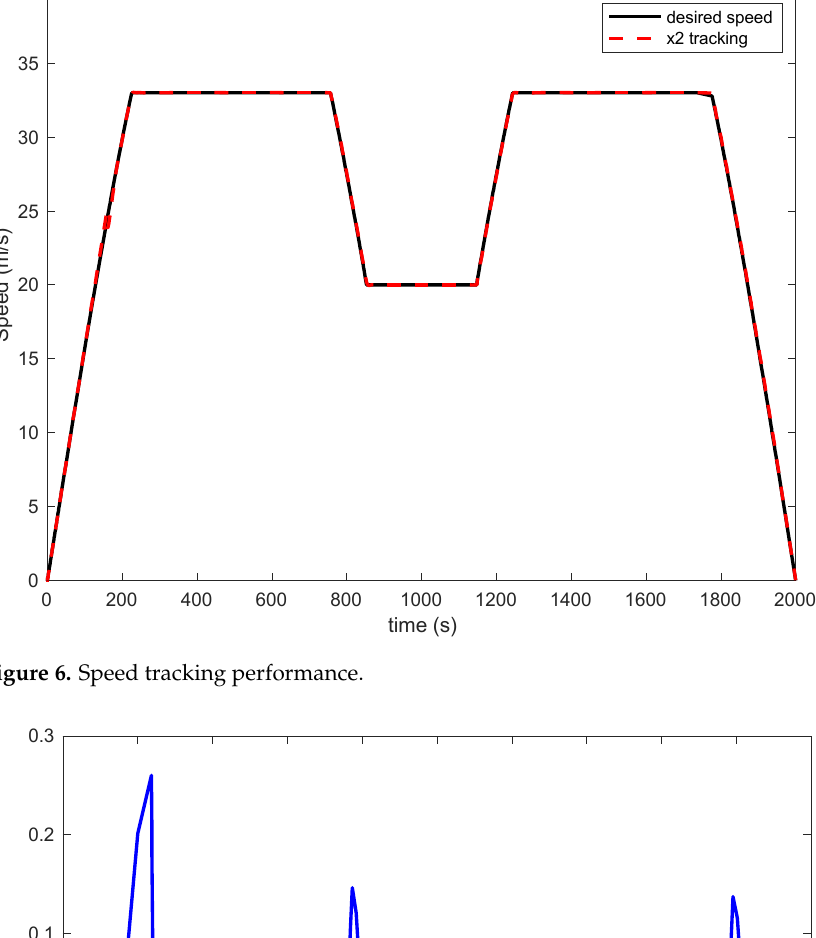
Figure 6. Speed tracking performance.